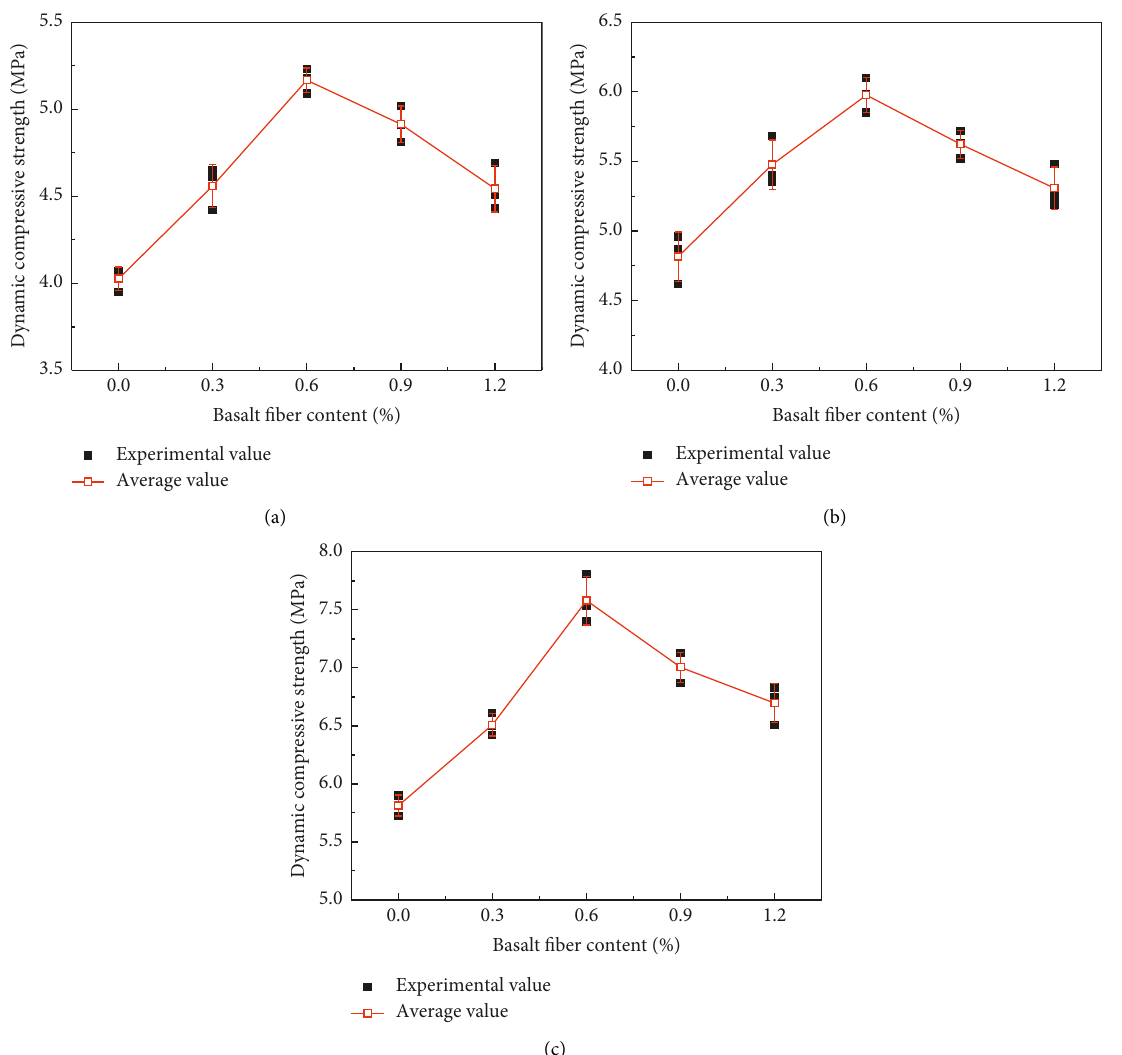
Figure 13: Dynamic compressive strength of basalt fiber-reinforced cement-fly ash-stabilized soil. (a) 0.3MPa impact loading pressure. (b) 0.4 MPa impact loading pressure. (c) 0.5MPa impact loading